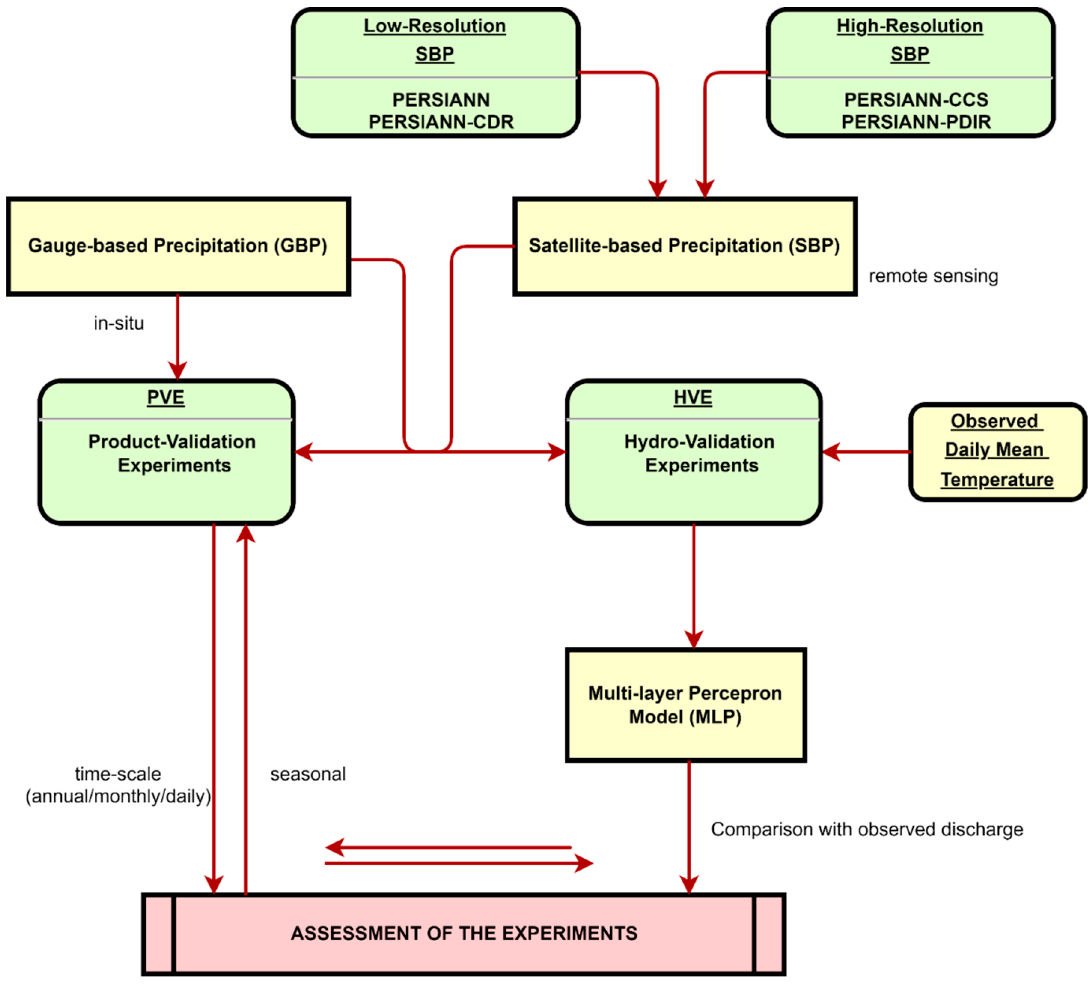
Figure 1. The flowchart of the study. Product-Validation Experiment (PVE): This experiment assesses the accuracy of the SBP data sets versus GBP. GBP is provided from long historical data sets of the meteorological station located in the basin. The experiments are conducted on different time scales, i.e., yearly, monthly, and